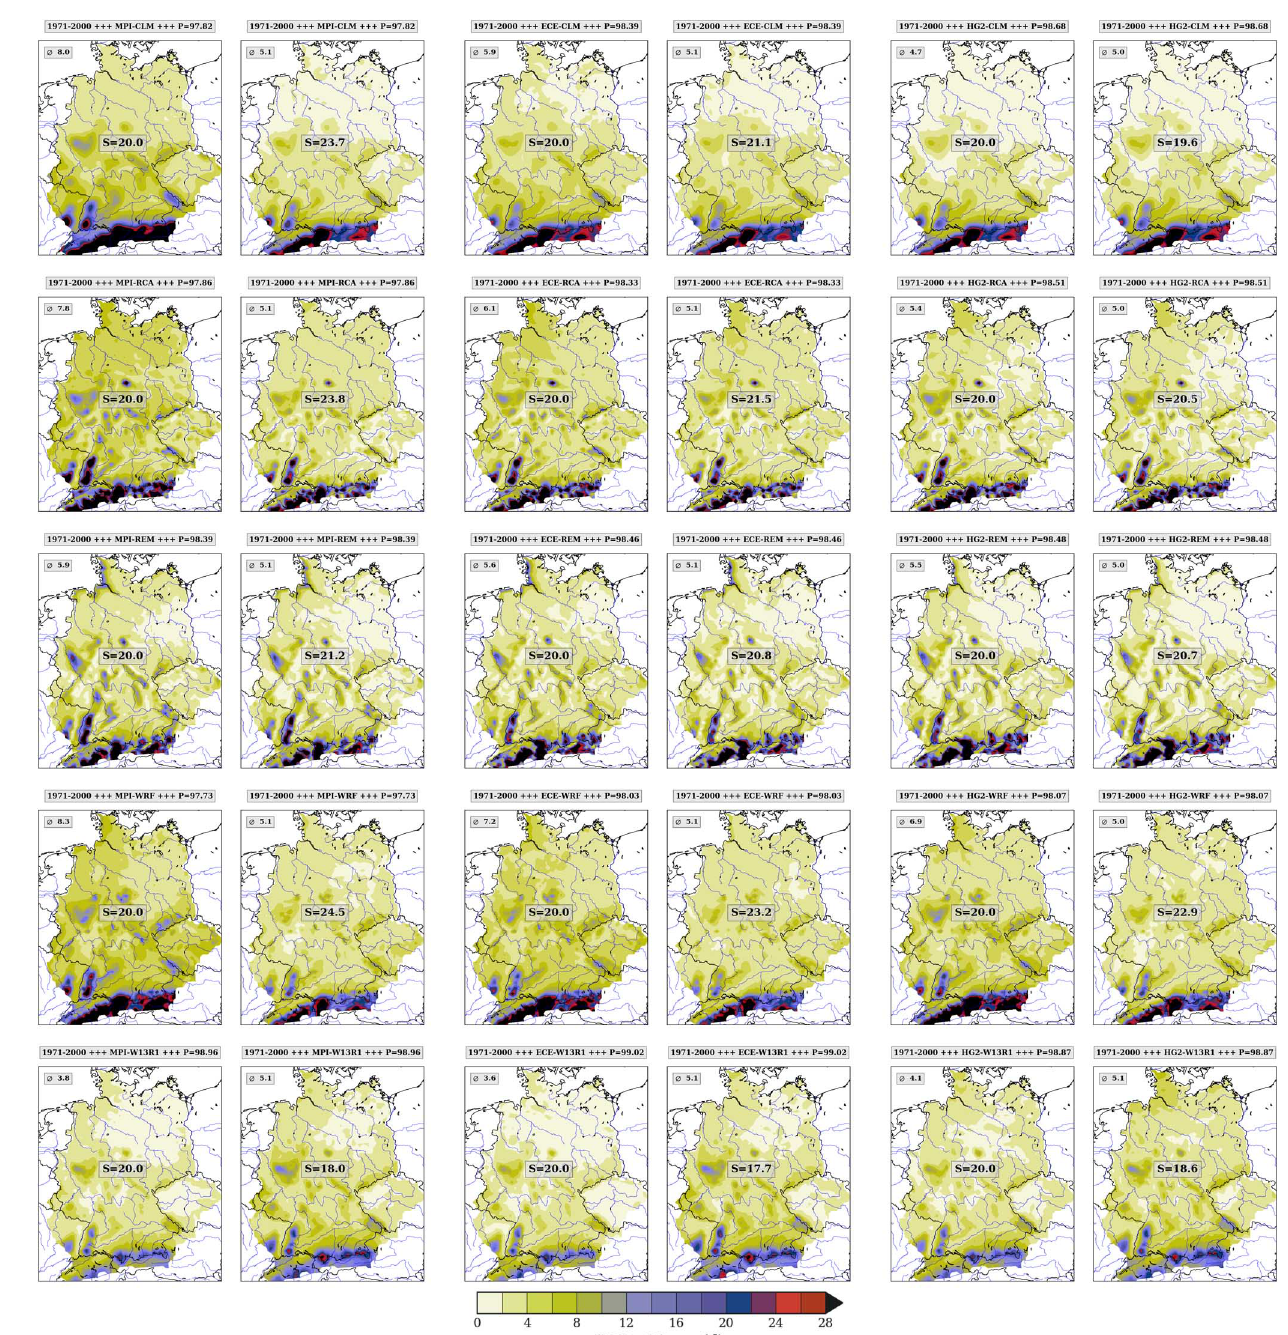
Figure 4. As in Fig. 3 but for r20mm (number of days with heavy precipitation of 20mm or